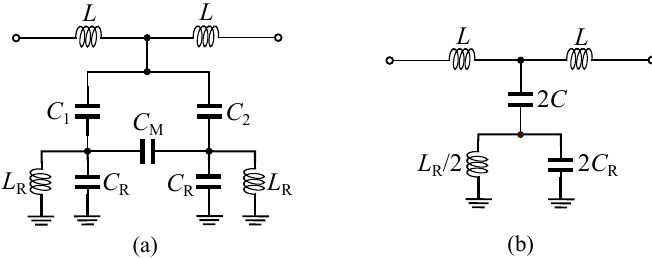
Figure 2. Equivalent circuit model of a microstrip line loaded with a MLC resonator. ( a ) General circuit model of the structure. ( b ) The circuit model, when the MLC electric wall is aligned with the magnetic wall of the microstrip transmission